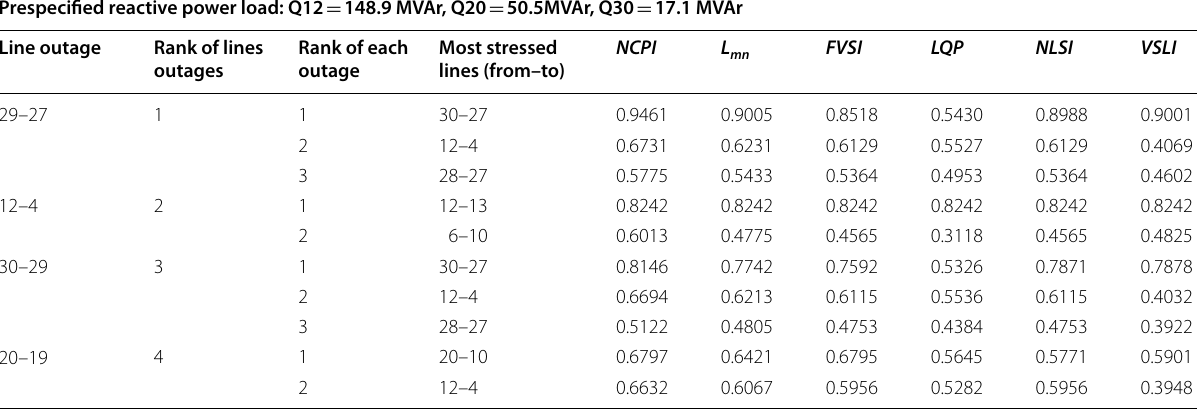
Table 10 Contingency ranking and analysis of the IEEE 30-bus system with pre-specified reactive power load